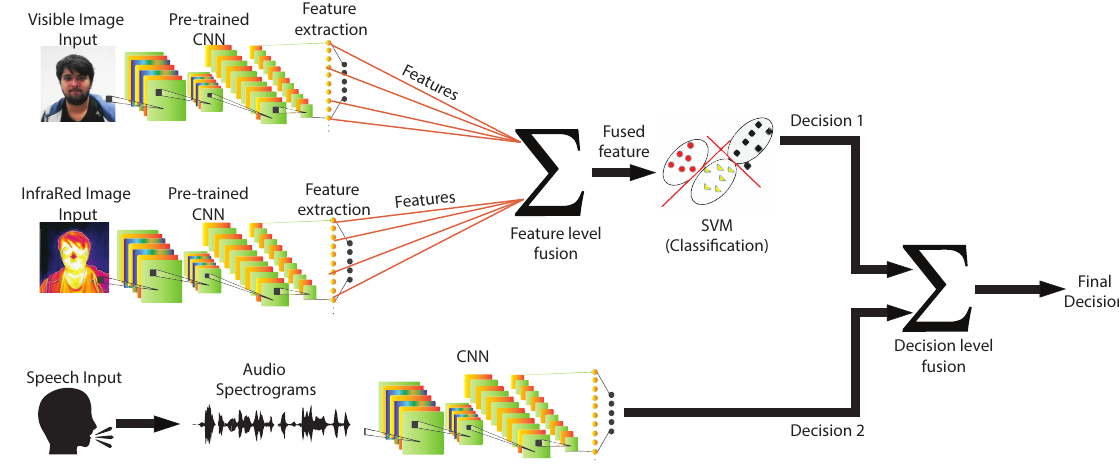
Figure 4. Proposed model for automatic emotion recognition (AER) using visible images, IR images, and